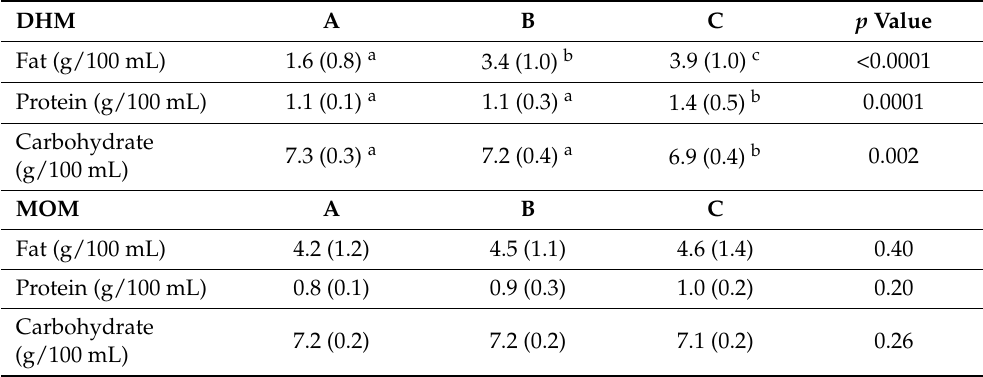
Table 4. Distribution of macronutrients across color categories given as the mean (SD). DHM Fat (g/100 mL)